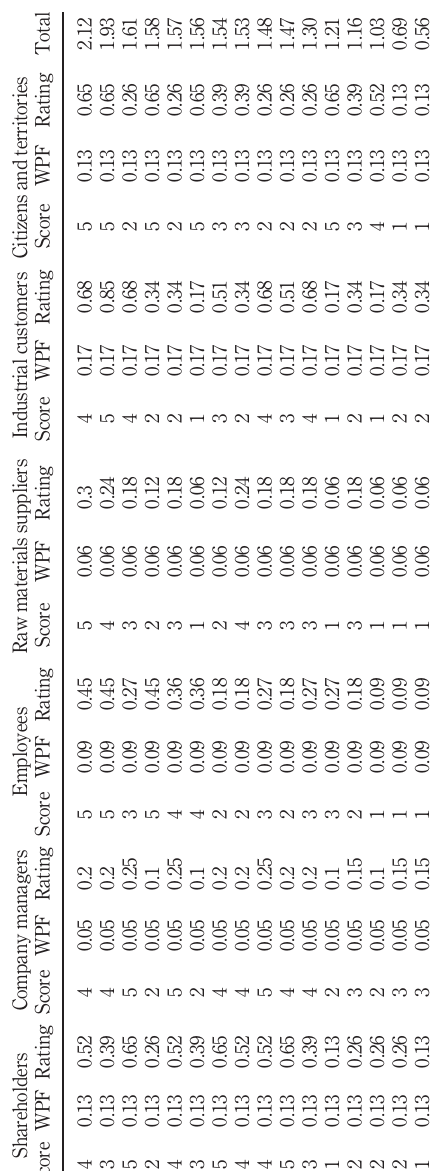
Table III. Construction of a rating for the names associated with business concepts based on the perception of